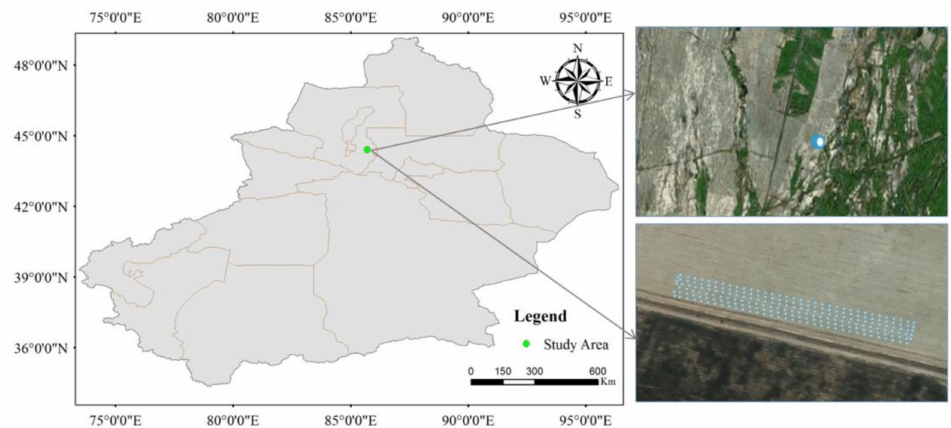
Figure 1. The location of the study area in Qitai County, Xinjiang, China (Left), the satellite image of the study area (upper right, data source from bing map), and the locations of captured images (Bottom